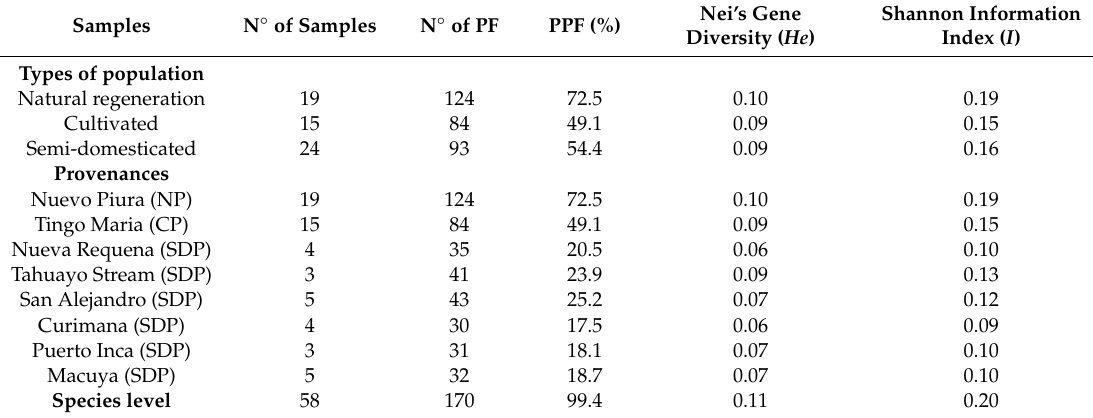
Table 3. Measurements of genetic diversity in three types of populations of G crinita: natural regeneration, cultivated and semi domesticated.